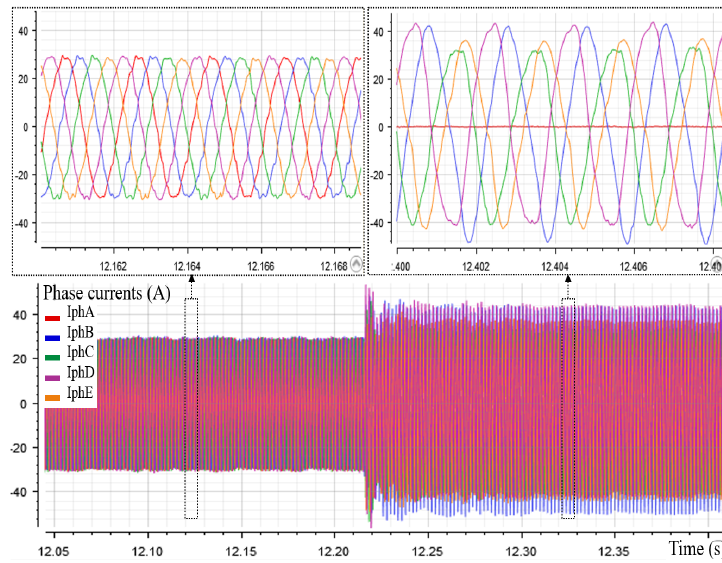
Figure 12. Phase currents before and after the fault on phase A.